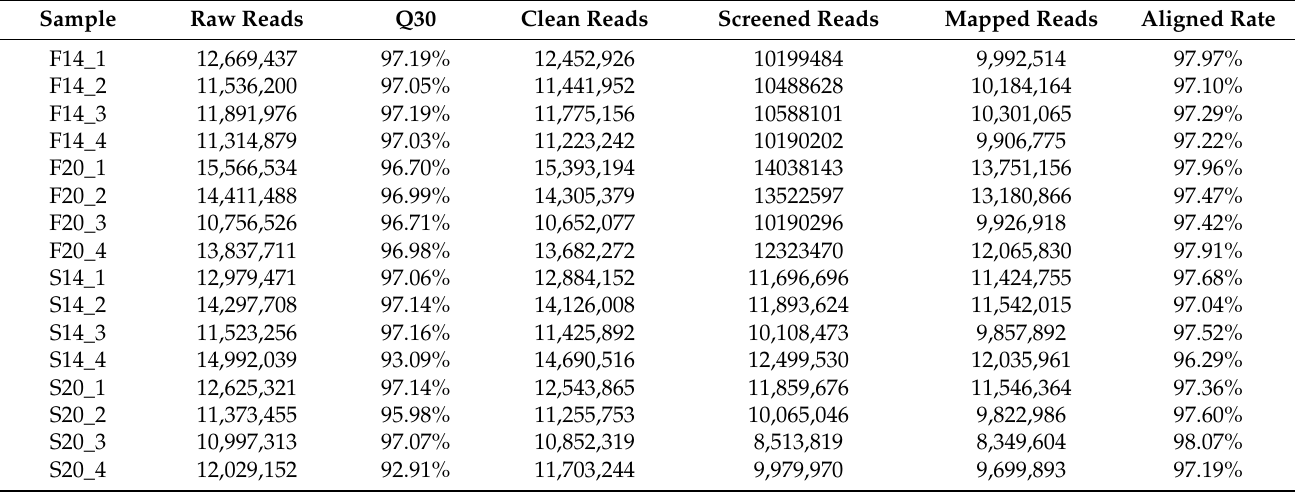
Figure 1. Distribution of length for miRNAs. ( A ) Distribution of length for miRNAs in F14; ( B ) distribution of length for miRNAs in F20; ( C ) distribution of length for miRNAs in S14; ( D ) distribution of length for miRNAs in S20. Table 1. Summary of the filter and mapping of leg muscle miRNA sequencing